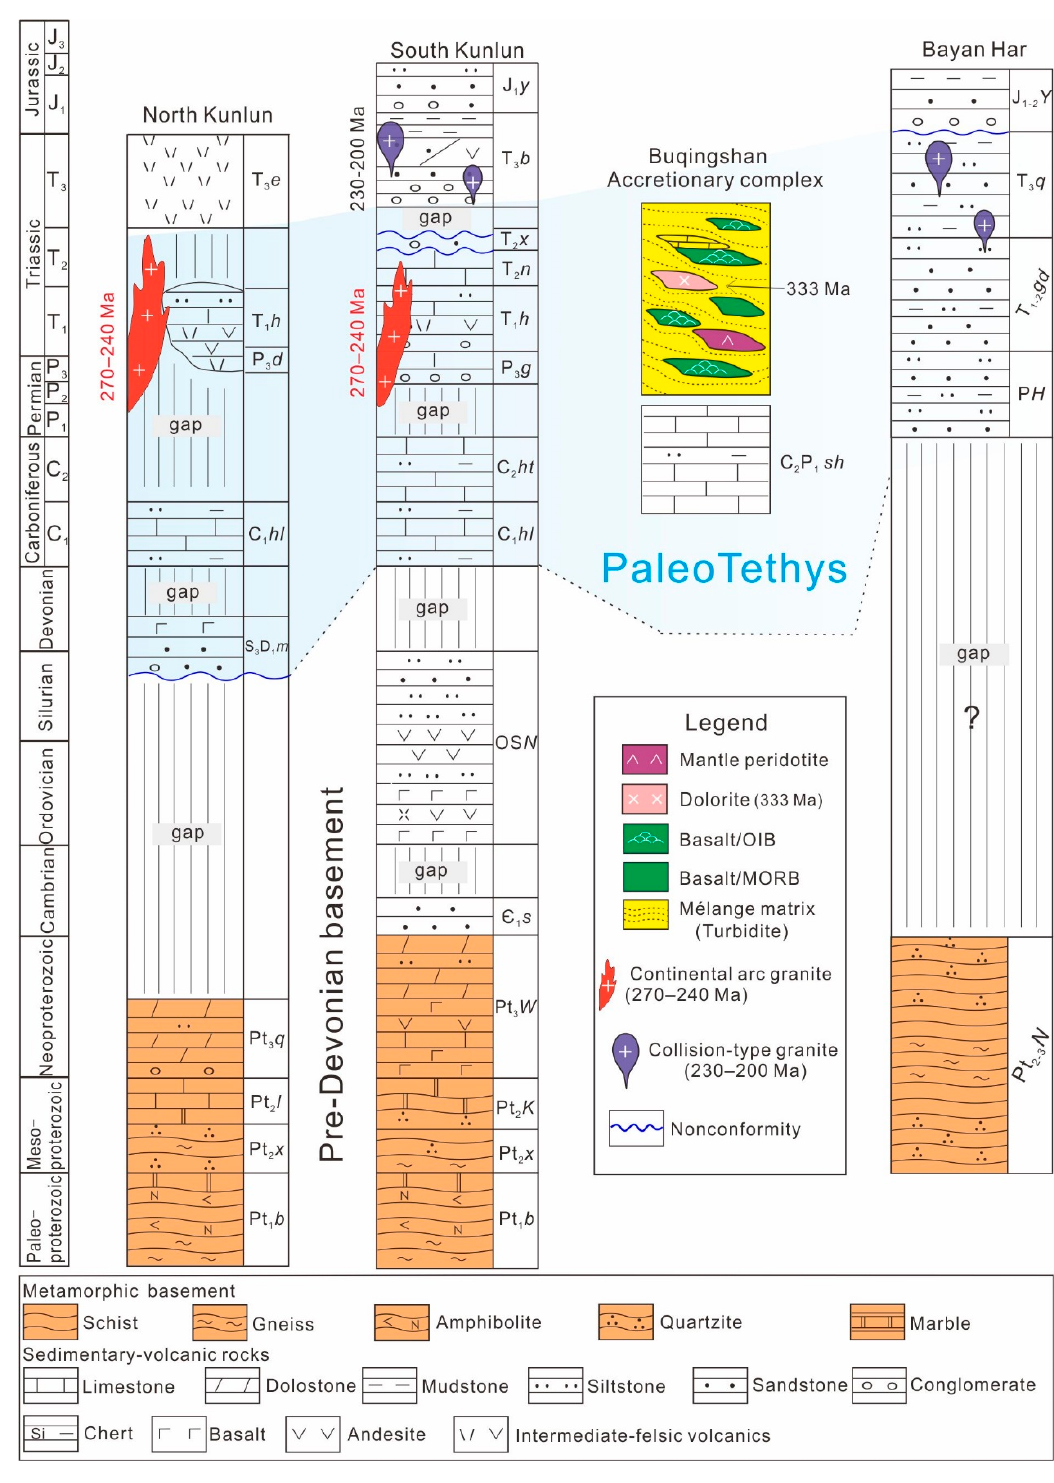
Figure 4. Stratigraphic columns for different tectonostratigraphic units in the East Kunlun orogen. No vertical scale. See text for more details. (Pt 1 b —Paleoproterozoic Baishahe Formation; Pt 2 x —Mesoproterozoic Xiaomiao Formation; Pt 2 K —Mesoproterozoic Kuhai Group; Pt 2 l —Mesoproterozoic Langyashan Formation; Pt 3 W —Neoproterozoic Wanbaogou Group; Pt 3 q —Neoproterozoic Qiujidong Formation; Pt 2-3 N —Mesoproterozoic to Neoproterozoic Ningduo Group; Є 1 s —Lower Cambrian Shasongwula Formation; OS N —Ordovician to Silurian Nachitai Group; Ss—Silurian Saishiteng Formation; S 3 D 1 m —Upper Silurian to Lower Devonian Maoniushan Formation; C 1 hl — Lower Carboniferous Halaguole Formation; C 2 ht —Upper Carboniferous Haoteluowa Formation; C 2 P 1 sh —Upper Carboniferous to Lower Permian Shuweimenke Formation; P 1-2 m —Lower to Middle